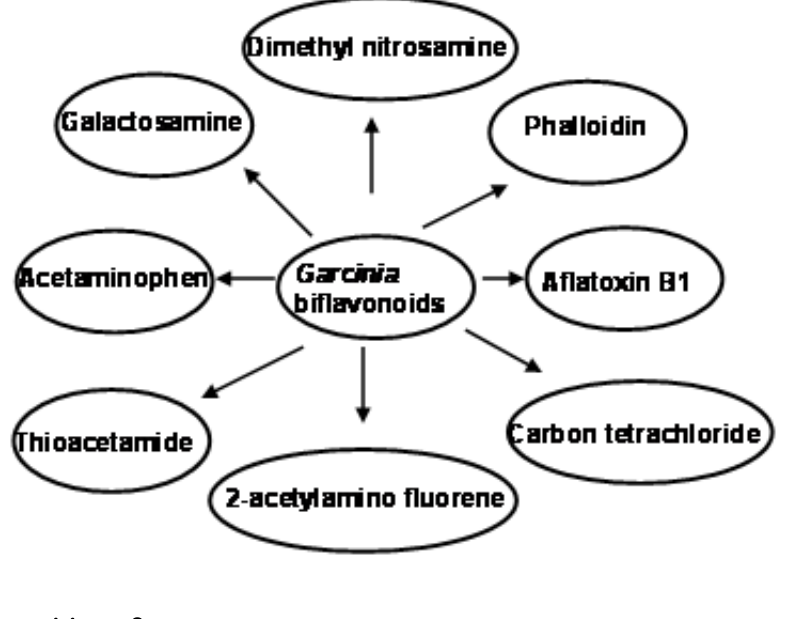
Figure 5. Hepatoprotective effects of Garcinia biflavonoids on selected